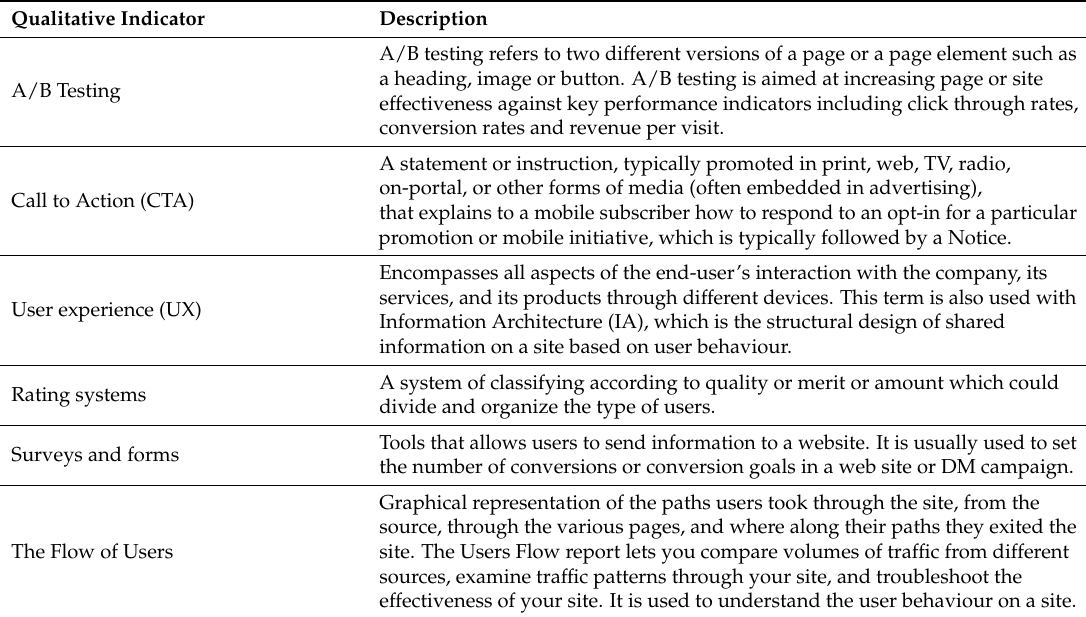
Table 7. Qualitative Indicators in